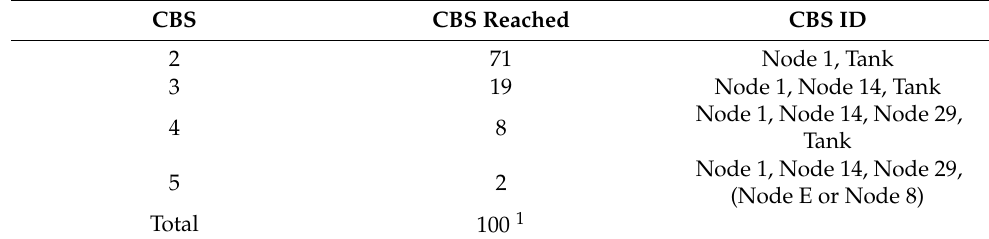
Table 2. Number of CBS distribution and frequency proposed by PSO, (statistical PSO location at Case 1).